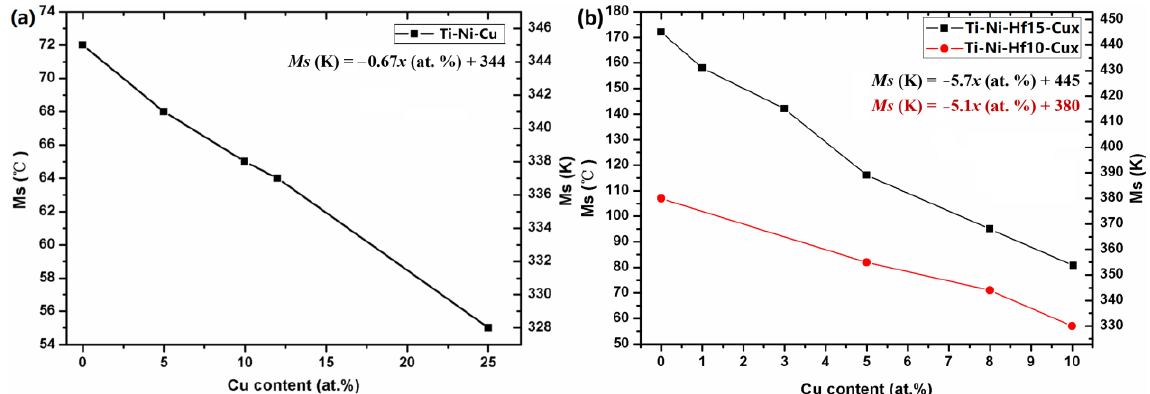
Figure 3. Influence of Cu content on M s of ( a ) Ti-Ni-Cu SMAs shows the M s decreases linearly with increasing Cu content, and ( b ) Ti 36 Ni 49 − X Hf 15 Cu X (labelled as Ti-Ni-Hf15-Cux) and Ti 41 Ni 49 − X Hf 10 Cu X (labelled as Ti-Ni-Hf10-Cux) alloys show linear decreasing M s as the Cu content increase in Ti-Ni-Hf-Cu alloys. The influence of Cu becomes stronger in higher Hf content alloys.